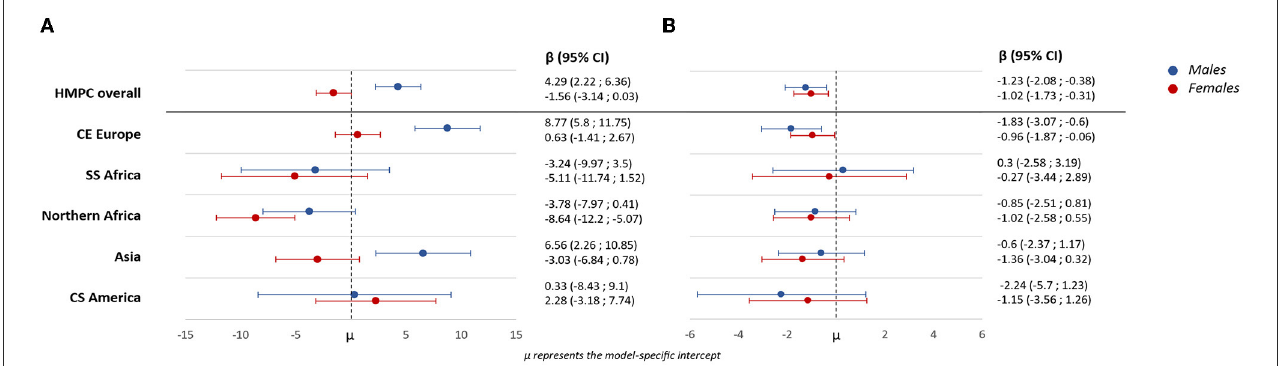
FIGURE2 β estimates and 95% confidence intervals of the associations between country of birth and total cholesterol (A) and systolic blood pressure (B) in relation to duration of residence and age at migration by sex.